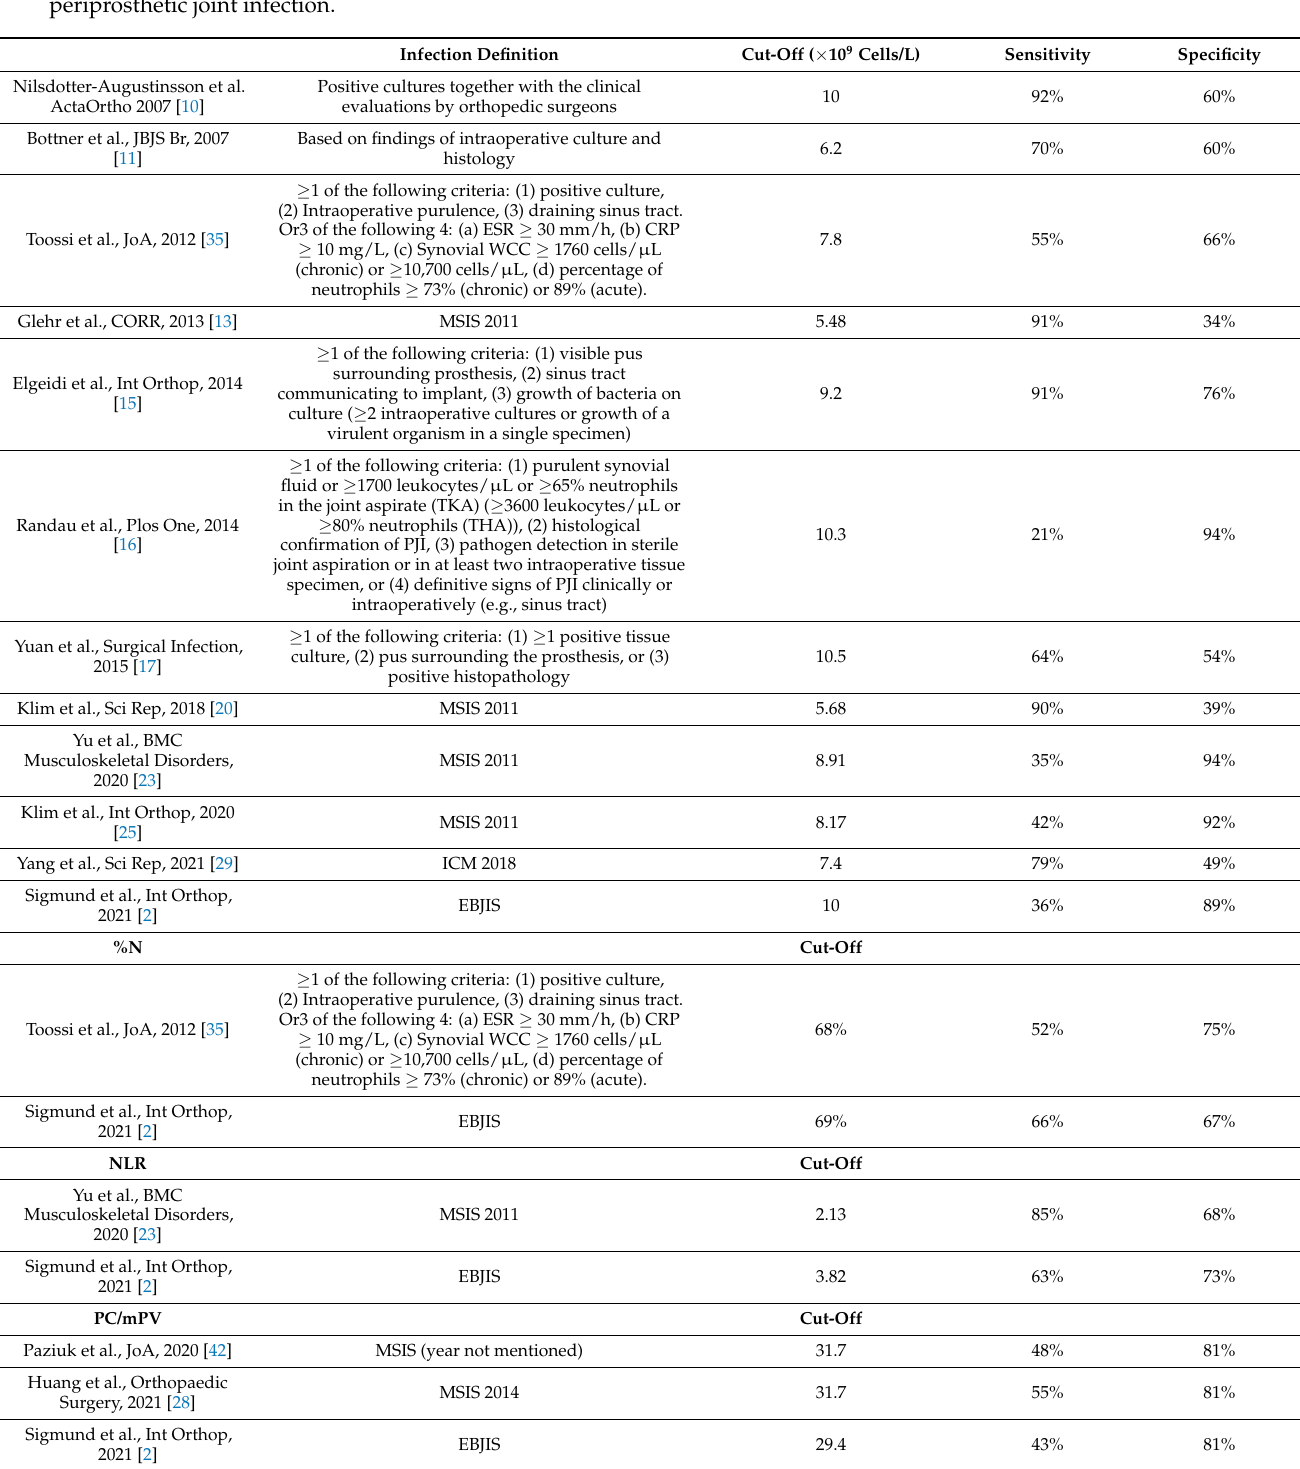
Table 3. Comparison of the literature regarding serum white blood cell count (WBC), percentage of neutrophils (%N), neutrophils to lymphocytes ratio (NLR), and platelet count to mean platelet volume ratio (PC/mPV) in the diagnosis of periprosthetic joint infection. Infection Definition Cut-Off ( × 10 9 Cells/L) Sensitivity